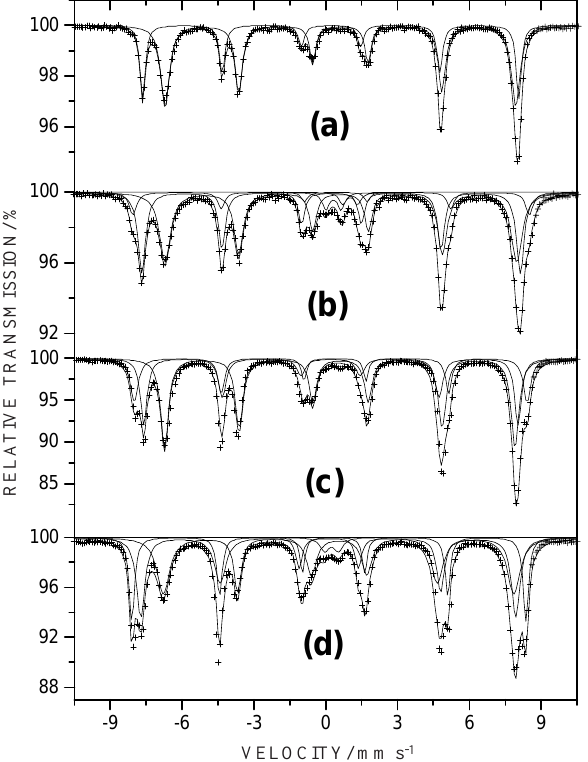
Figure 2. Room temperature Mössbauer spectra of untreated magnetic extracts from (a) fresh rock; (b) altered rock; (c) soil-sand and (d)